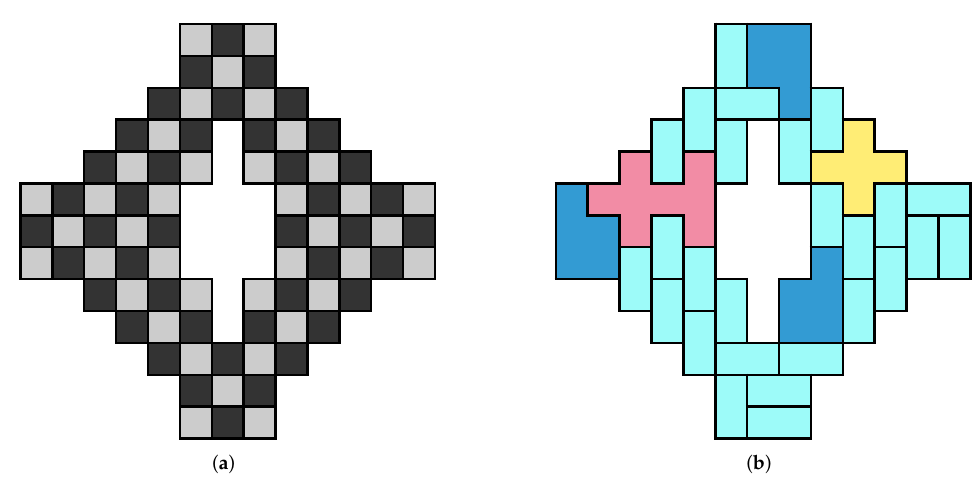
Figure 21. Target region and a tiling solution for Example 9: ( a ) The checkerboard coloured target region (cid:98) R ; ( b ) Successful tiling of the target region (cid:98) R using 26 copies of a domino, 3 copies of the P-shaped pentomino, one copy of the cross-shaped pentomino, and one copy of an octomino. The optimal solution corresponds to the first pariomino tiling subproblem in Table 5 using 26 copies of P + , three copies of P − , one copy of P + , and one copy of P + . The pariominoes P + , P − , P + , and P + 2 3 2 3 1 4 1 4 are coloured light blue, blue, yellow and red,